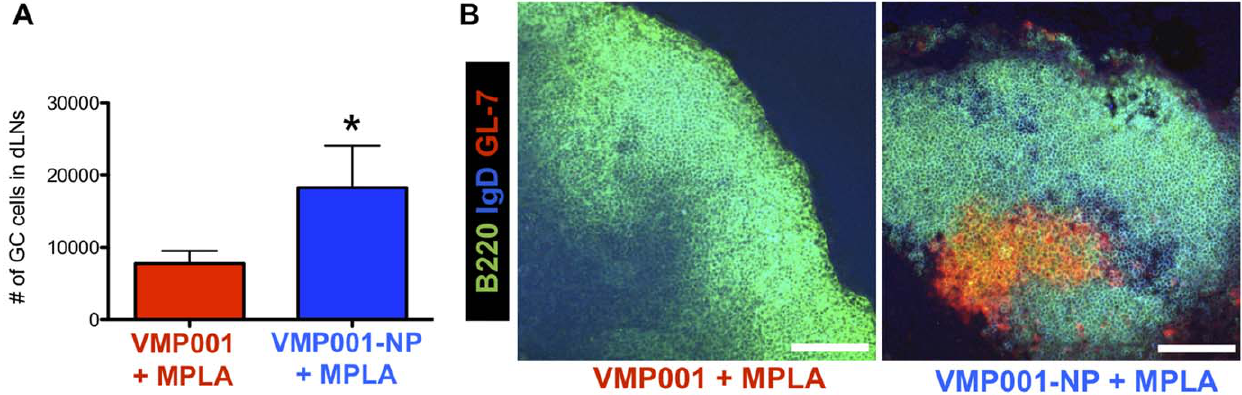
Figure 5. VMP001-NP immunization triggers germinal center formation. (A) C57Bl/6 mice were vaccinated with 0.1 m g VMP001 and 5 m g MPLA in either soluble or VMP001-NP formulations, and on day 21, inguinal dLNs were isolated and analyzed for germinal center formation. The number of isotype-switched germinal center B cells (GL-7 + PNA + ), gated on B220 + IgD low populations in dLNs was measured with flow cytometric analysis. (B) Inguinal dLNs were cryo-sectioned on day 21 post-immunization and stained with anti-B220, anti-IgD, and anti-GL-7 (markers for B cells, immature B cells, and germinal center, respectively) and examined by confocal microscopy. Scale bars, 50 m m. *, p , 0.05, analyzed by Student’s t test.